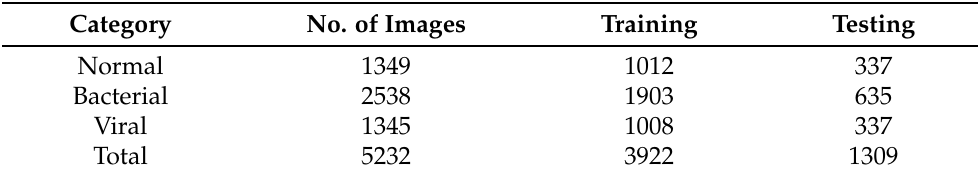
Table 1. Training, Validation, and testing CXR image number using Kaggle CXR dataset.